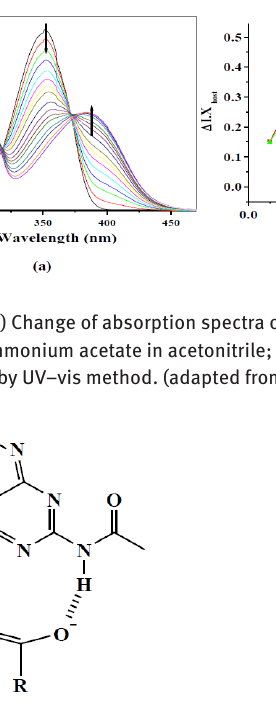
Figure 31: Possible binding mode of carboxylate anions.